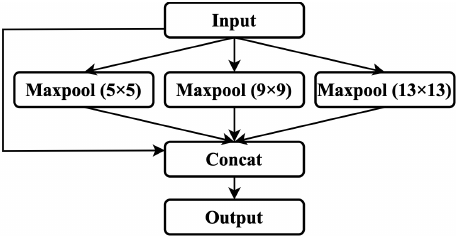
Figure 4. Network structure with a spatial pyramid pooling